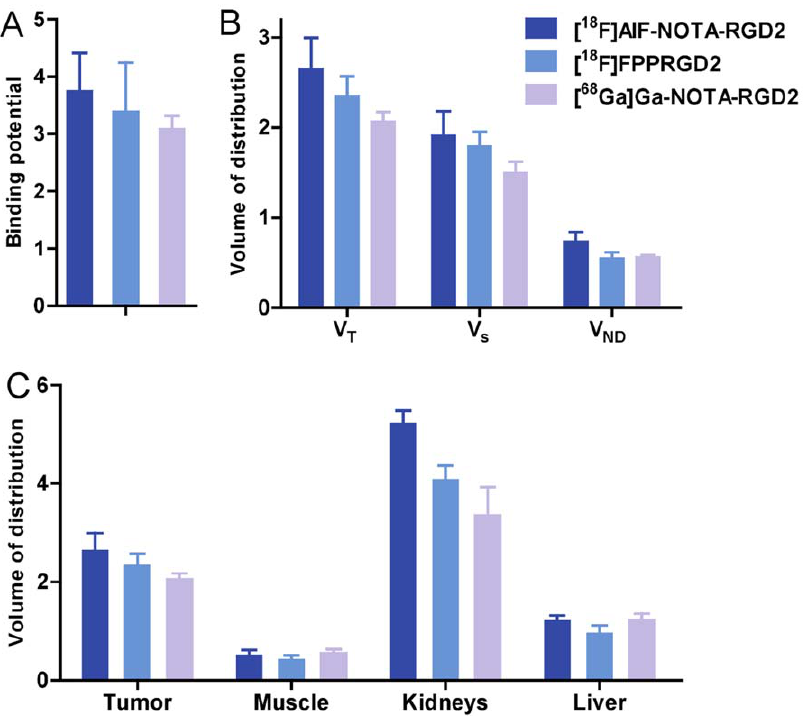
Figure 6. ( a ) Binding potential (Bp ND ) of 18 F-labeled RGD peptide tracers. ( b ) Volumes of distribution (V T ) of 18 F-labeled RGD peptide tracers. The Bp ND was calculated as k 3 /k 4 reflecting the binding affinity, and the volume of distribution (V T =K 1 /k 2 (1 + k 3 /k 4 )) reflects the tissue-to-plasma concentration ratio. V T can be regarded as the sum of specific (V S =K 1 ? k 3 /(k 2 ? k 4 )) and nonspecific (V ND =K 1 /k 2 ) distribution. ( c ) Volume of distribution of tumor, kidneys, muscle and liver.